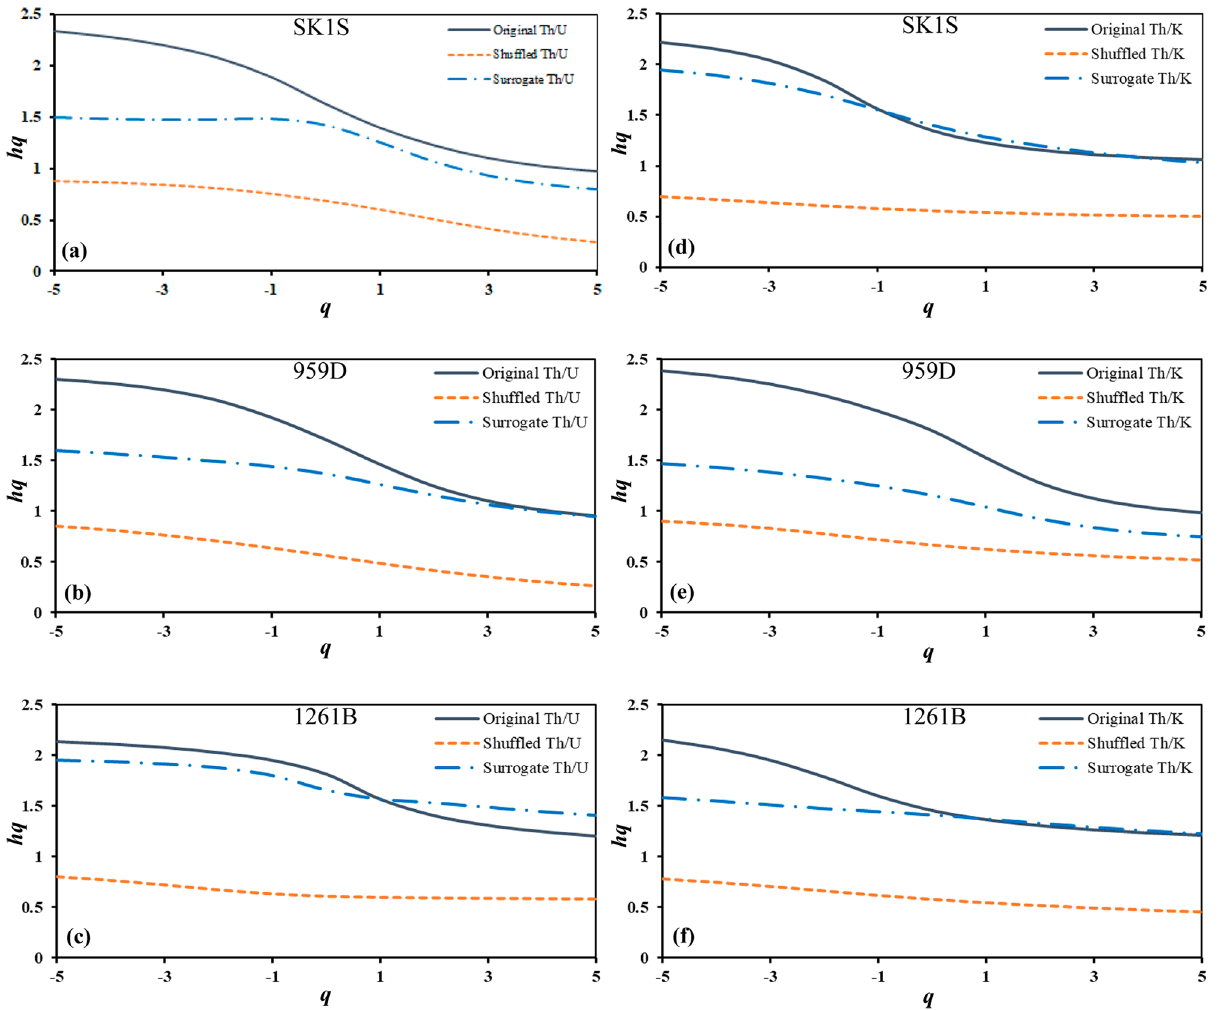
Figure 7. The generalized Hurst exponent of shuffled and surrogate data series computed based on the original thorium–potassium and thorium–uranium distributions in the studied OAE3 intervals recorded in Songliao Basin (SK1S): ( a , d ); Deep Ivorian Basin (959D): ( b , e ); Demerara Rise (1261B): ( c , f